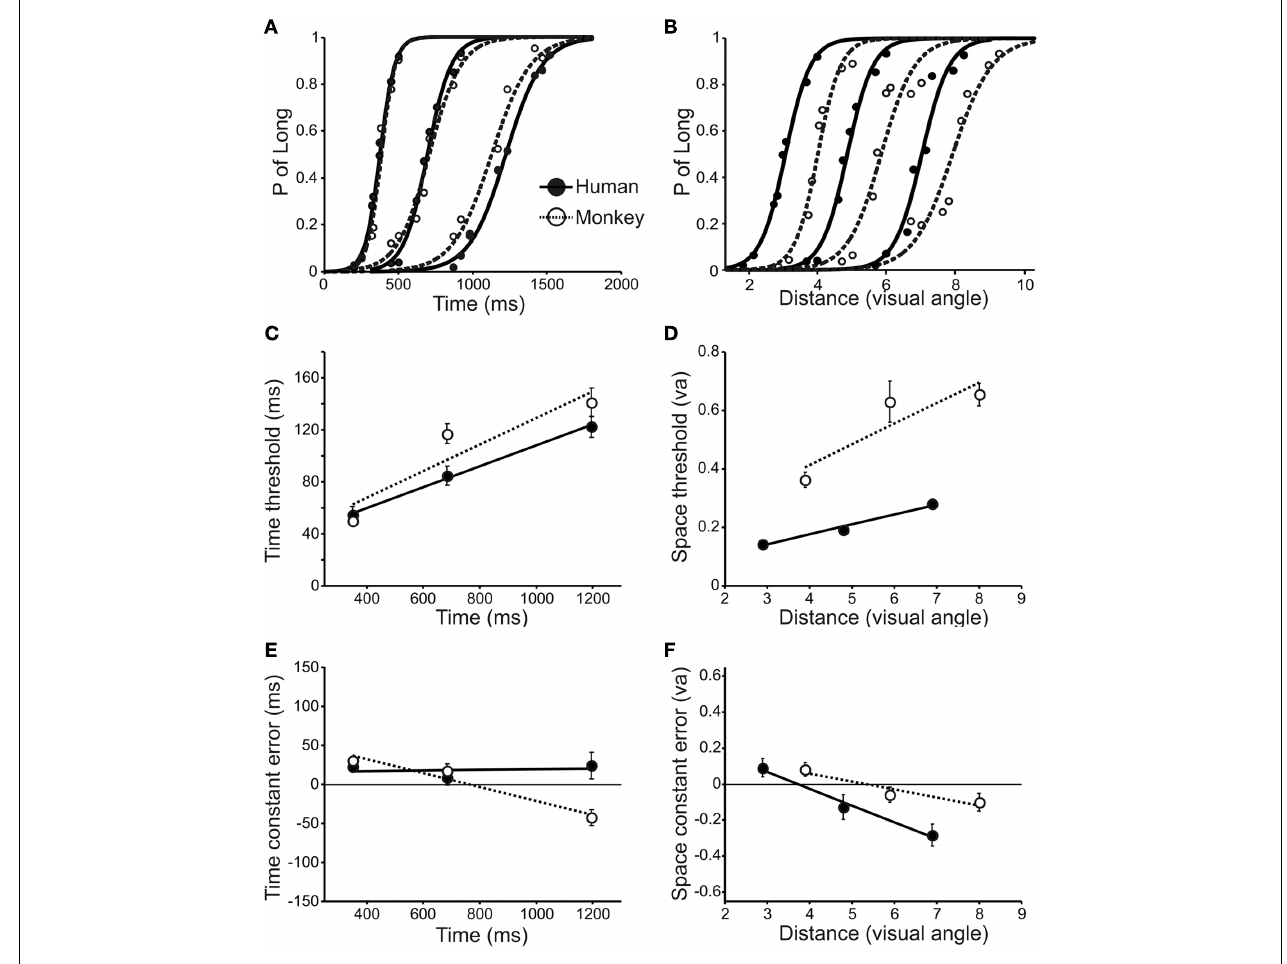
values duringTCT (E) and SCT (F) ; the horizontal line at zero corresponds to perfect accuracy. For thresholds and constant errors the lines correspond to the best linear regression models. Human subjects are depicted in solid lines and filled circles and the monkey in dotted lines and open circles.